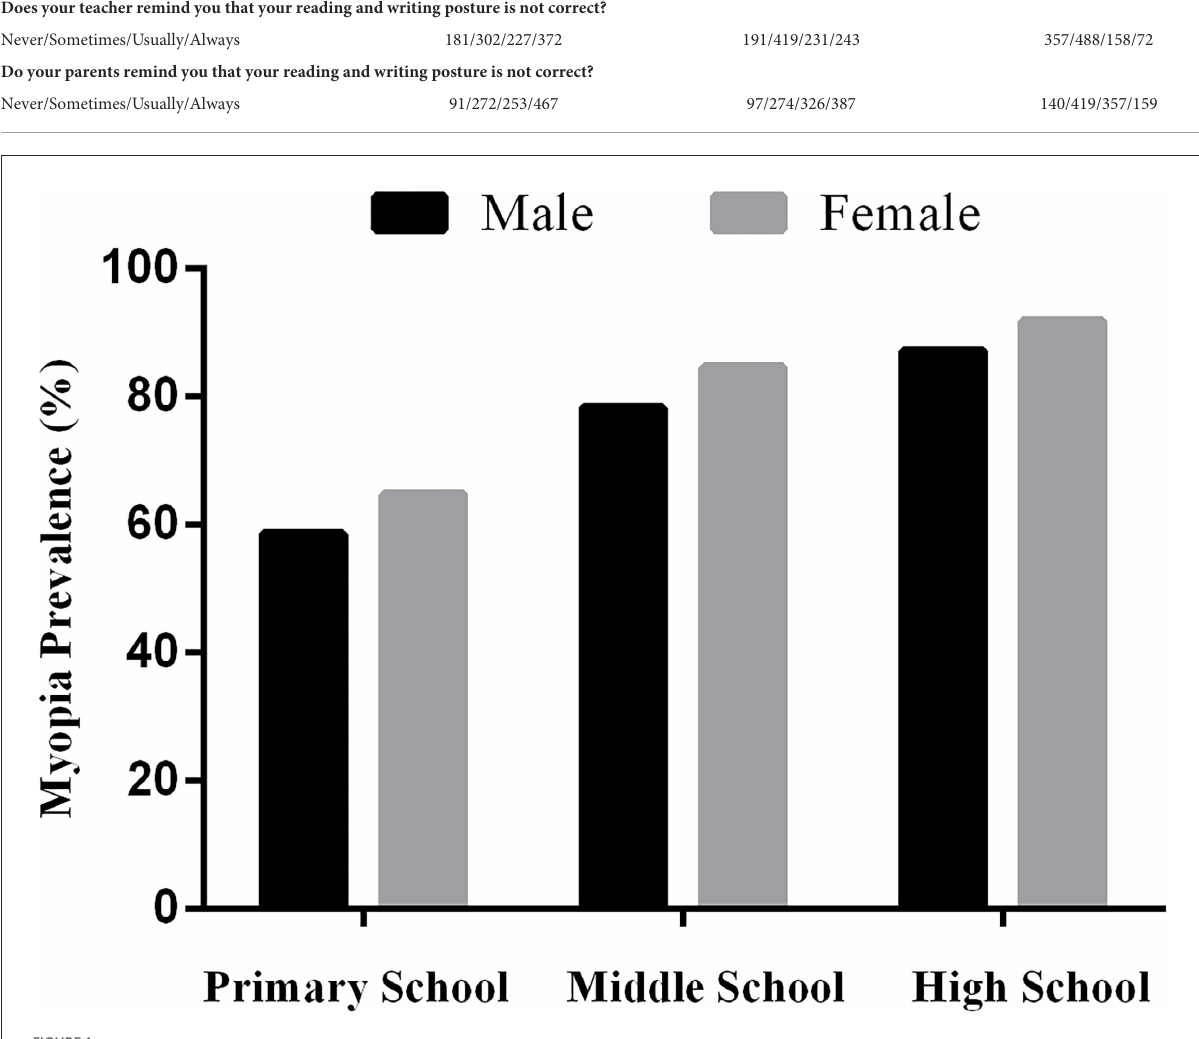
FIGURE1 Prevalence of myopia among school students by